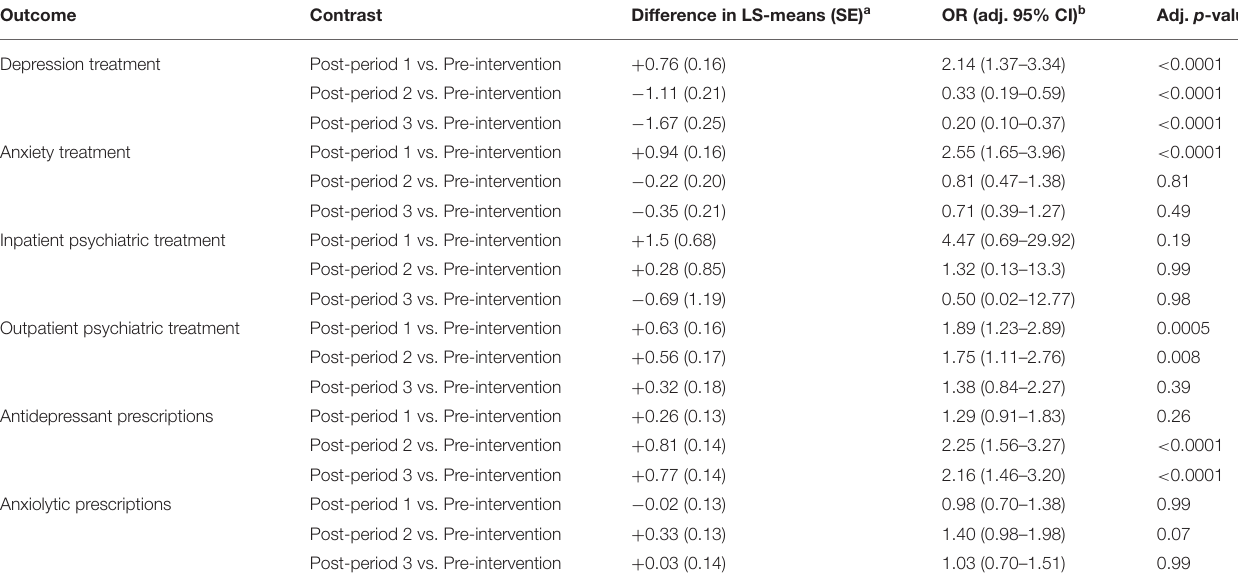
TABLE 2 | Comparison of mental health utilization between post- and pre-intervention periods. Outcome Contrast Difference in LS-means (SE)